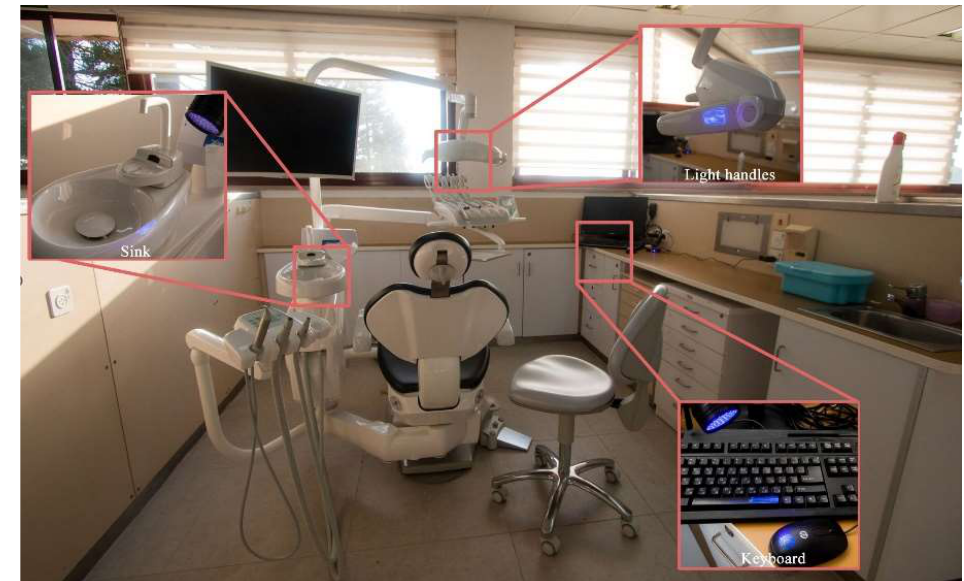
Figure 3. Example of surfaces examined in students’ working cubicles.